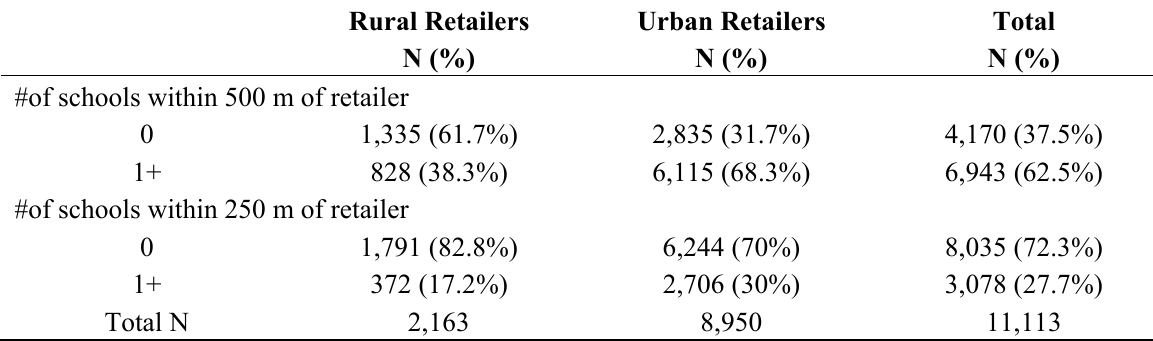
Table 3. Number of retailers within walking distance of a school.